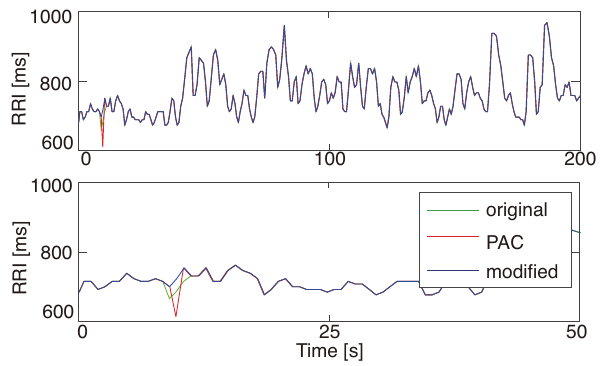
Figure 9. The RRI modification result of PAC. The blue, red, and green lines represent the original RRI data, the RRI data with artificial PVC data, and the RRI data modified by DAEM, respectively. This figure shows that the modified RRI was very close to the original RRI data.